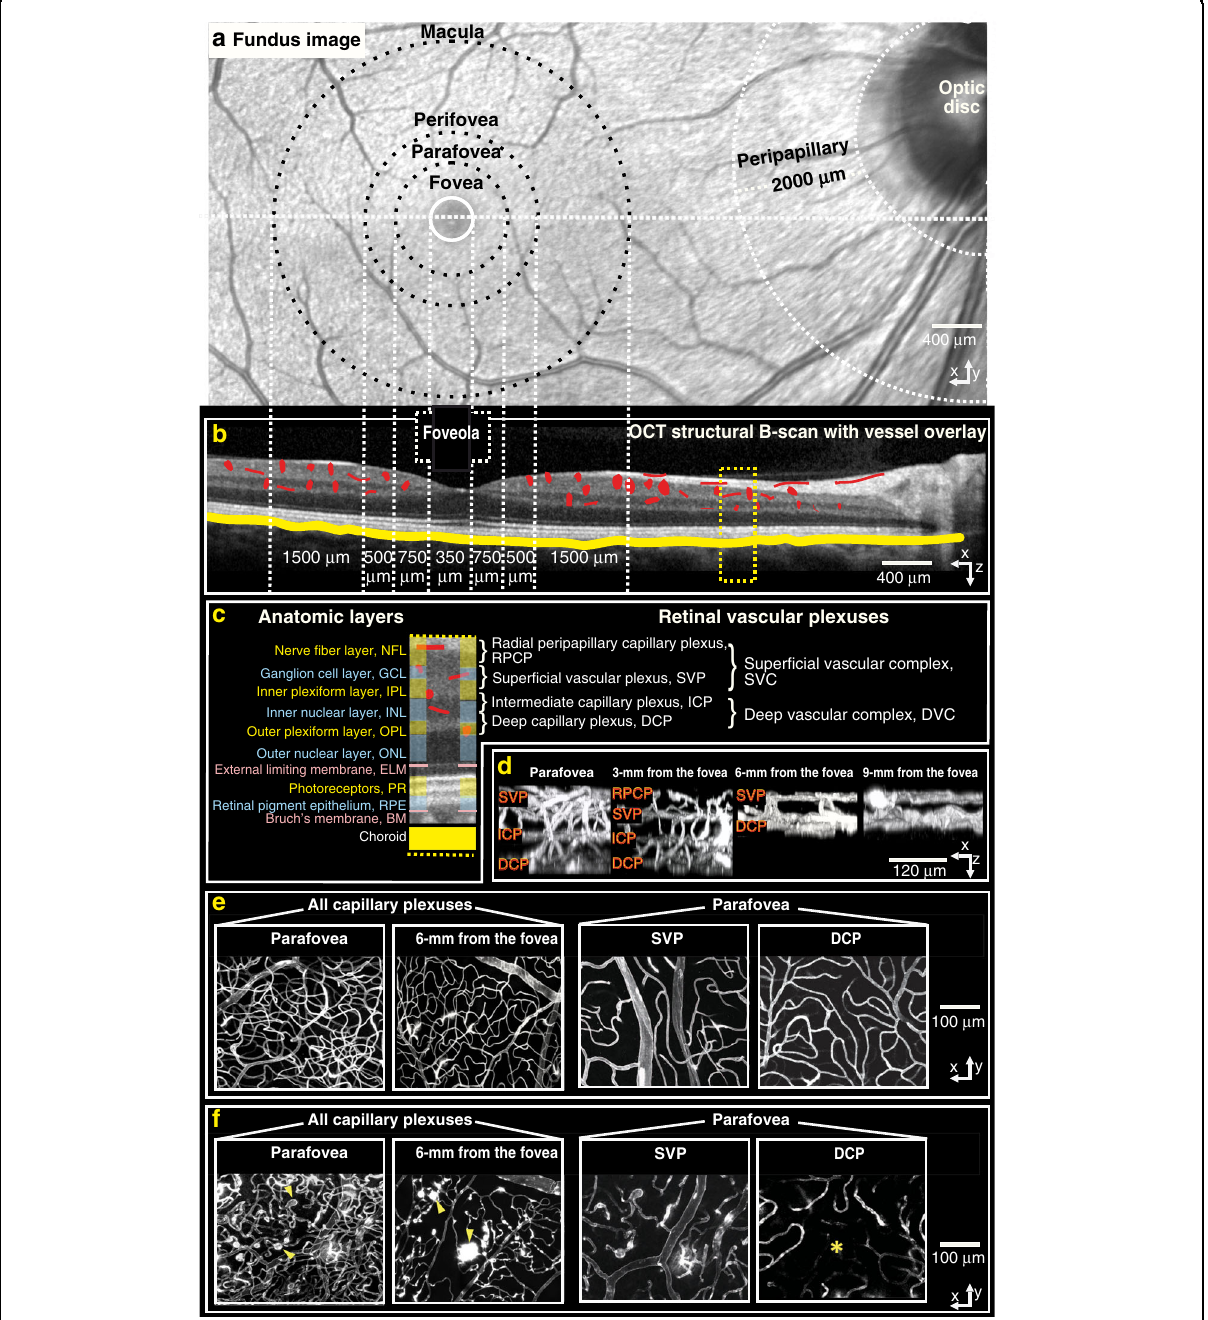
Fig. 3 Retinal microvasculature in practice. a Fundus camera image from a healthy volunteer with marked retinal sections 190 ; b Matched OCT structural B-scan with detected vessel overlay; red — retinal and yellow — choroidal vessels; c anatomic localization on the OCT image of the retinal vascular plexuses and their names; d Confocal microscopy ex vivo showing in-depth organization of retinal vasculature at different transverse distances (eccentricities) from the fovea; e , f Confocal microscopy fundus view of retinal vasculature at different eccentricities (left) and different plexuses from the parafoveal region (right). Images in d , e and f obtained from deceased human donor eyes perfused with fl uorescent contrast agent without retinal disease ( d , e ) and with diabetic retinopathy ( f ) Yellow arrows in f indicate microaneurysms and the yellow star marks an area of impaired capillary perfusion. Reduced vessel density in the subject with diabetic retinopathy is observed. d , e , f Adapted with permission from An et al.